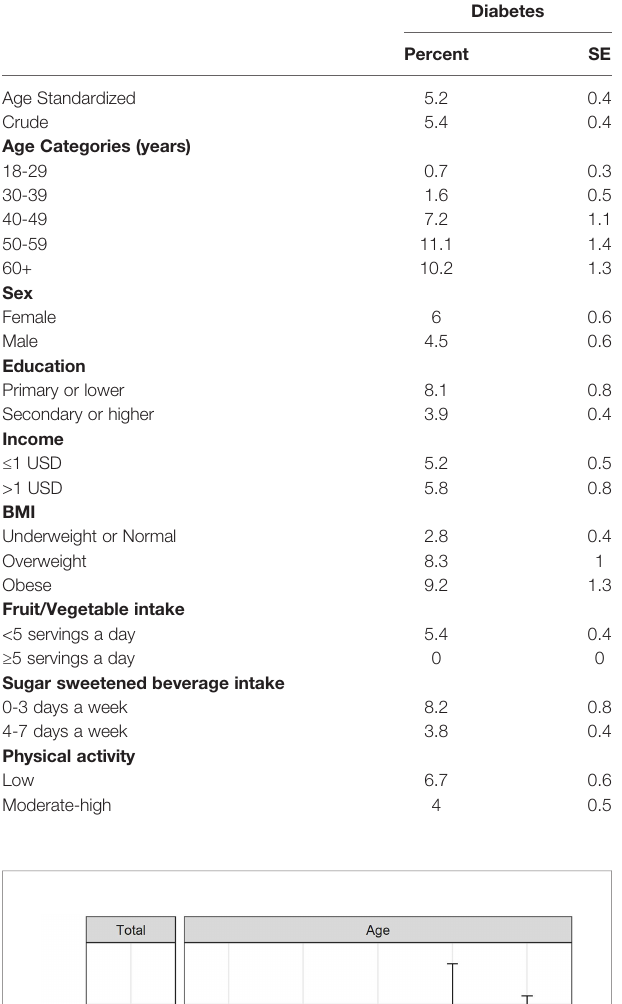
TABLE 2 | Prevalence of